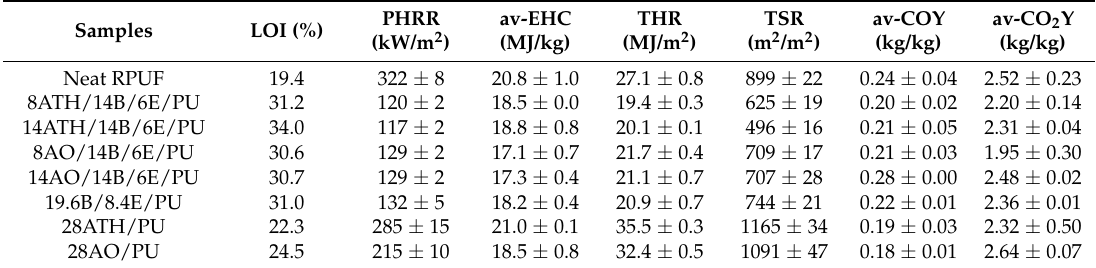
Table 2. Tested results of LOI and cone calorimeter test (0–400